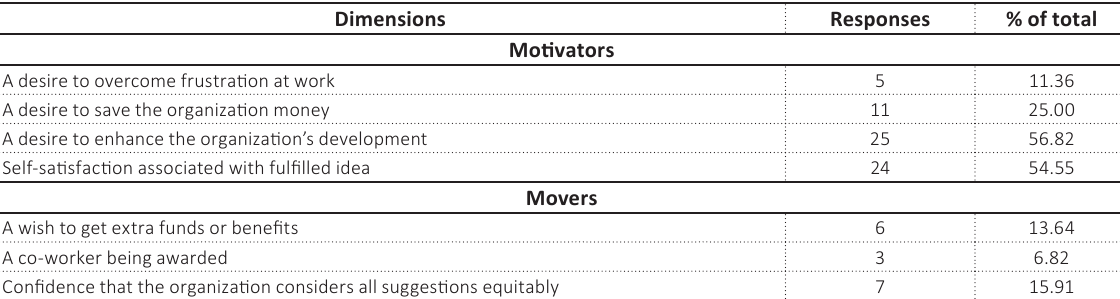
Table 7. Employee responses to motivators and movers